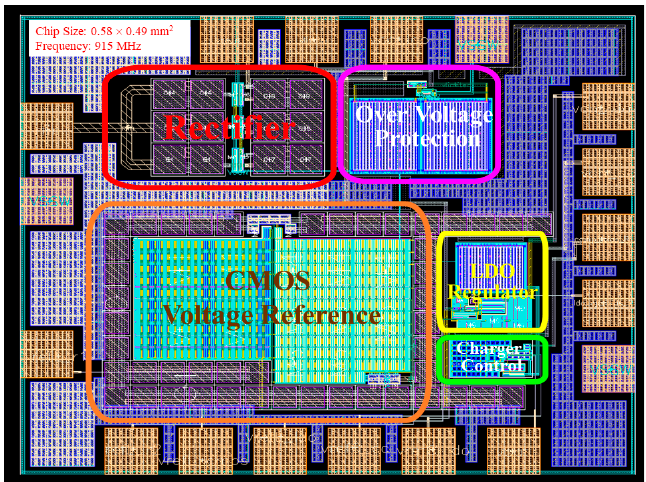
Figure 15. Layout of the proposed RF-energy-harvesting IC.